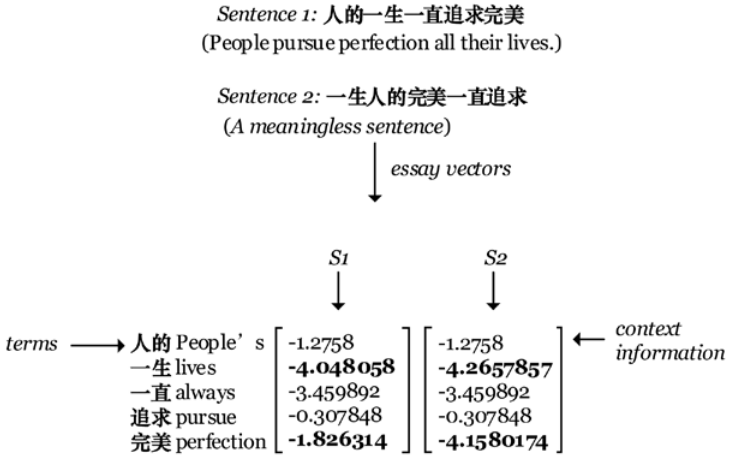
Figure 5: Context Information Applied to the Example in Figure 2. When we consider context information extraction using WFST and the n -gram language model, we see that the two sentences are not identical